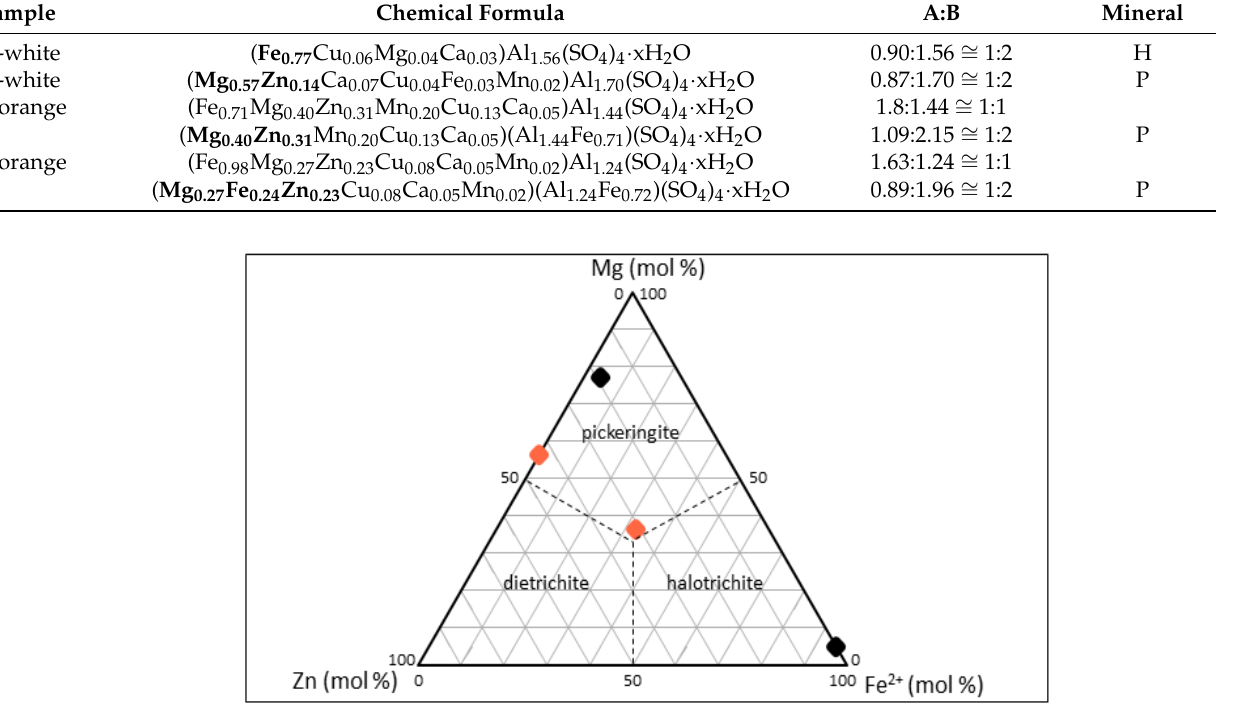
Figure 8. Ternary diagram [36] Fe 2+ /Mg/Zn (in terms of mole percent) for the Algares samples from the halotrichite group (based on XRF data); orange diamonds—orange samples; black diamonds—white samples.